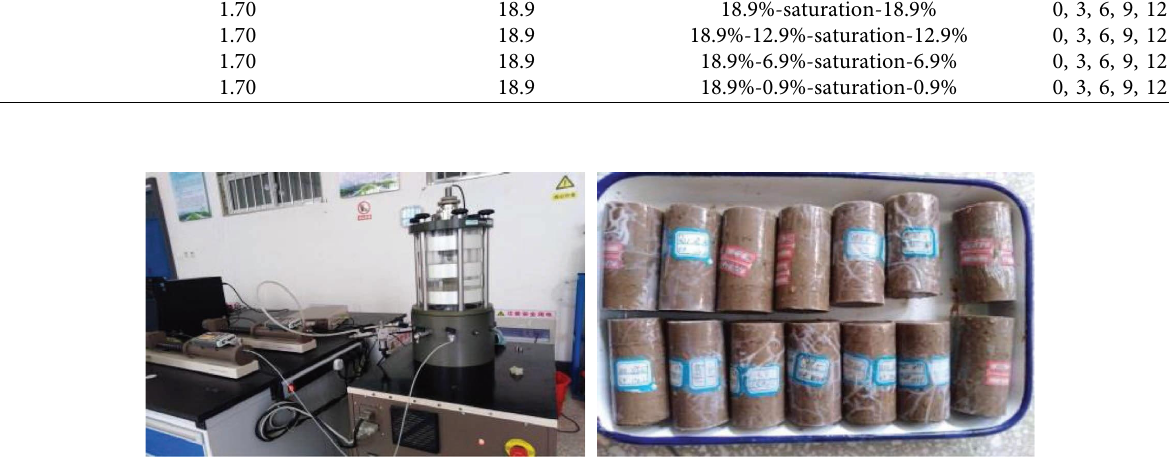
Figure 1: Dynamic triaxial testing apparatus and some W - D cycle samples. Table 3: Te scheme of dynamic triaxial